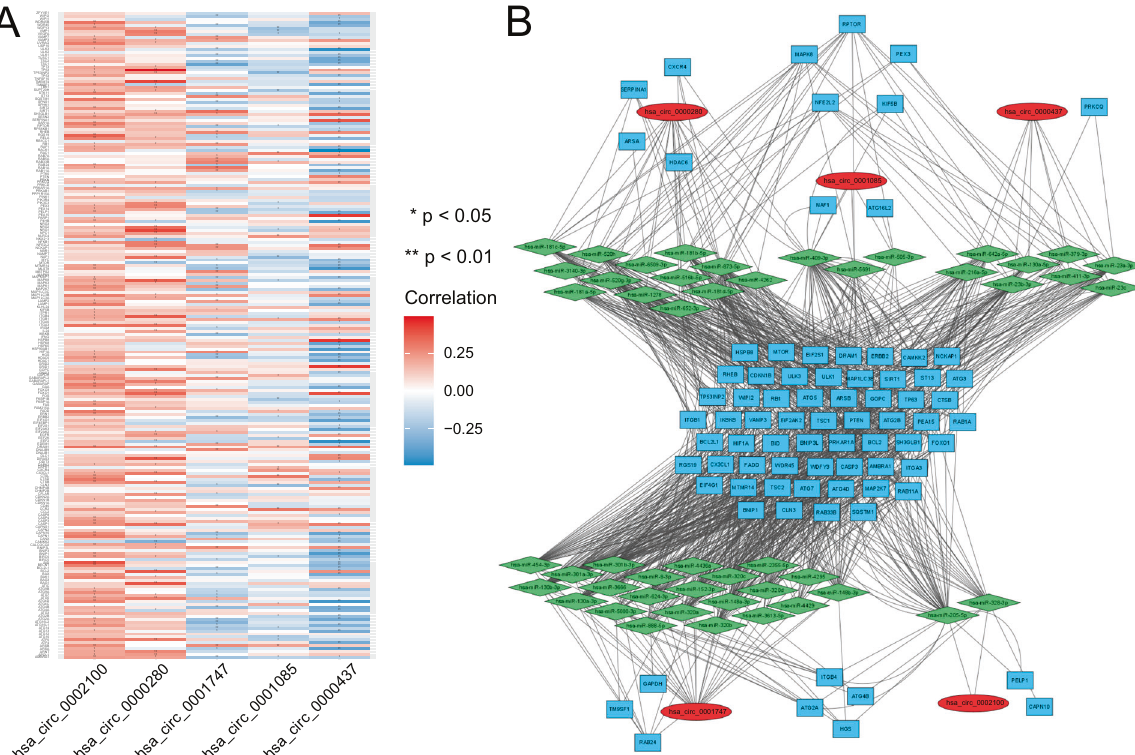
Fig. 6 Correlation and network of fi ve autophagy-related circRNAs, downstream miRNAs, and autophagy-related genes. A Heatmap of correlation between fi ve circRNAs and 210 autophagy-related genes. B CeRNA network analysis of the fi ve circRNAs, downstream miRNAs and miRNA-targeted autophagy-related